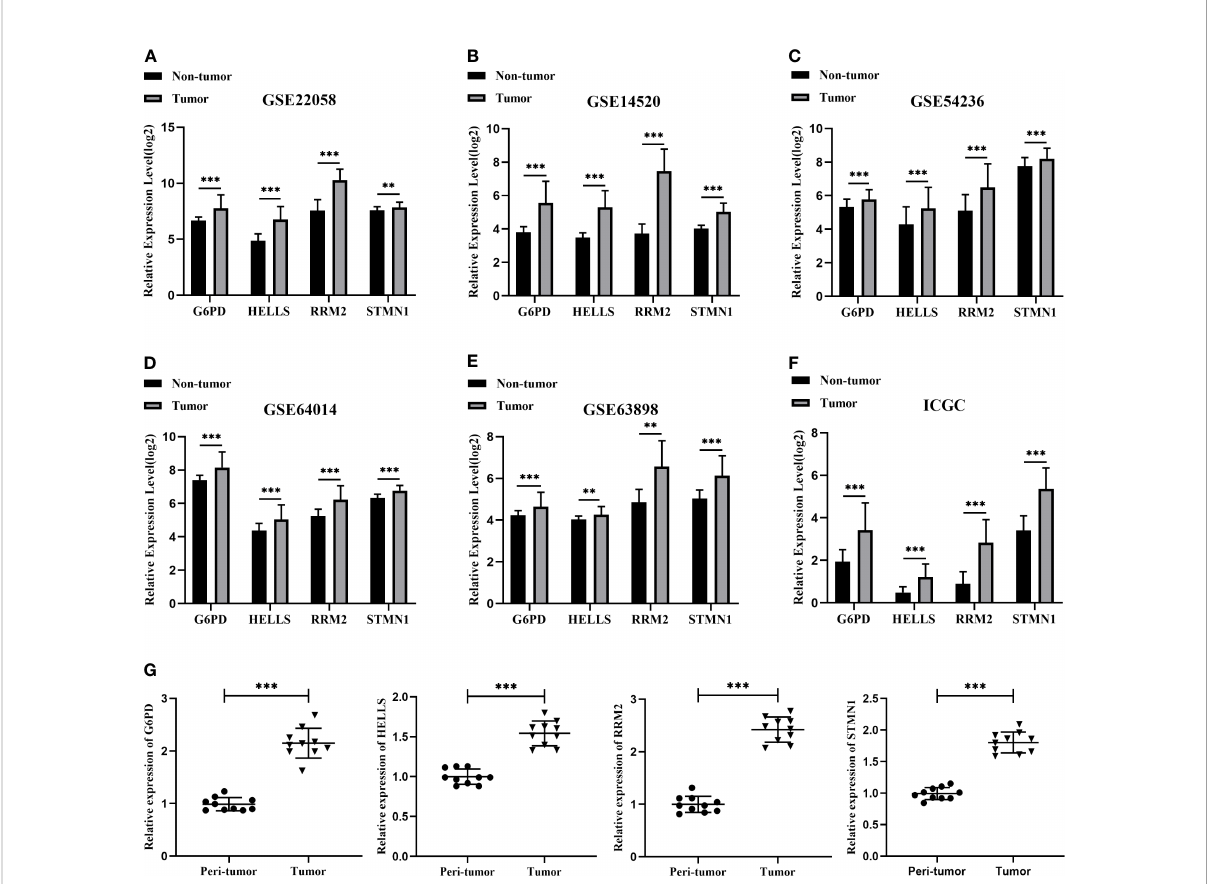
FIGURE 5 Validation of the mRNA expression for four hub FRGs. (A) Validation of four hub FRGs in GSE22058. (B) Validation of hub FRGs in GSE14520. (C) Validation of four hub FRGs in GSE54236. (D) Validation of four hub FRGs in GSE64014. (E) Validation of four hub FRGs in GSE63898. (F) Validation of four hub FRGs in ICGC. (G) Scatter plots of G6PD, HELLS, RRM2, and STMN1 were constructed using qRT-PCR data of our own patients ’ cohort. (*P <0.05; **P <0.01; ***P